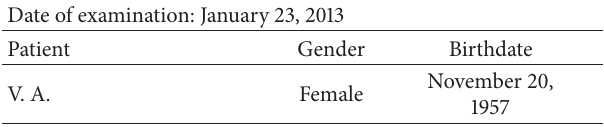
Table 1: Ophthalmological